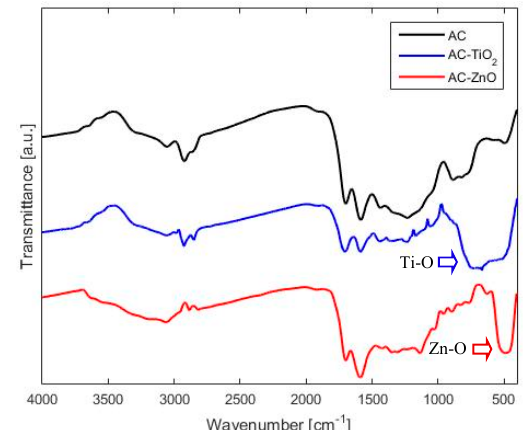
Figure 4. FT-IR spectra.